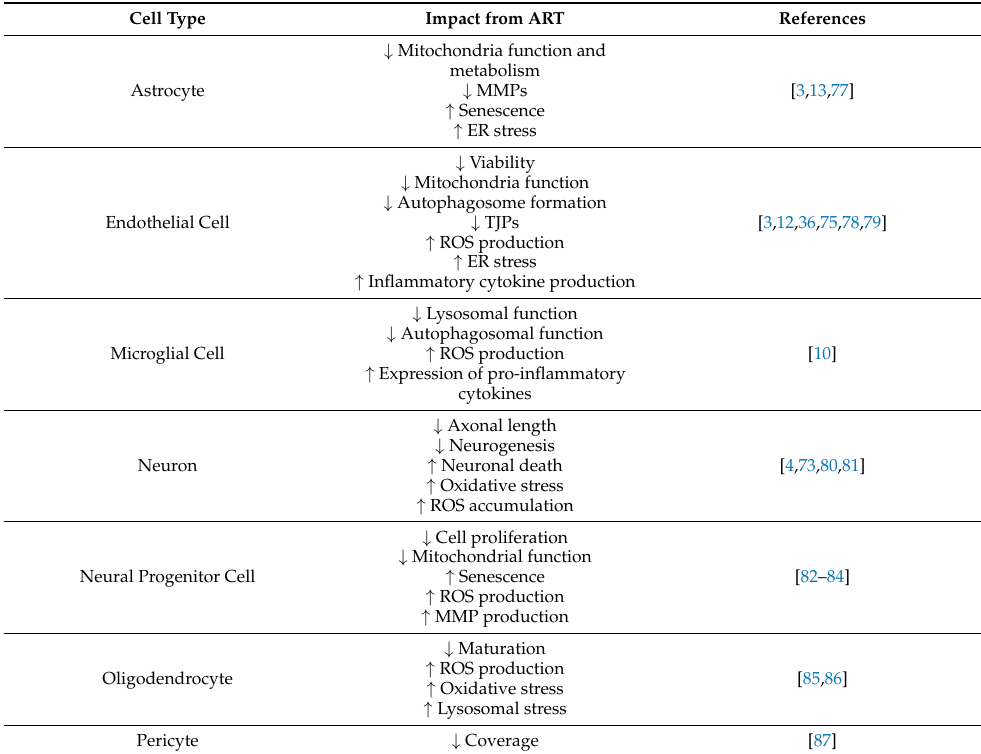
Table 2. Known effects of ART on cells of the